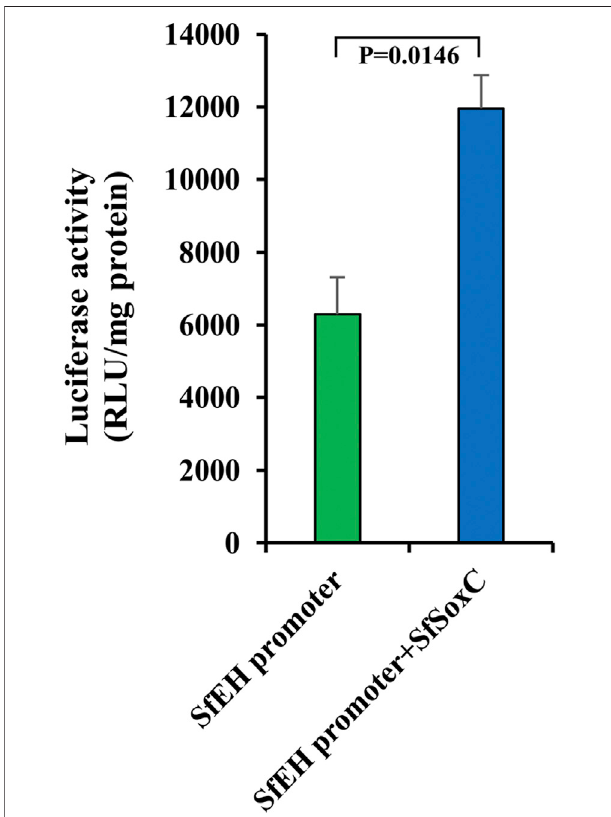
FIGURE 6 | The SfSoxC activates the expression of SfEH . Luciferase reporter assays in Sf9 cells. Sf9 cells were co-transfected with a reporter construct ( SfEH/P2574-pG5luc ) containing the SfEH promoter region (from − 2574 to the start codon) and an expression construct ( pIEx-4-SfSoxC ) containingtheORFof SfSoxC .Thecellswereharvestedathraftertransfection and the luciferase activity was determined. Means ± SE of three independent experiments are